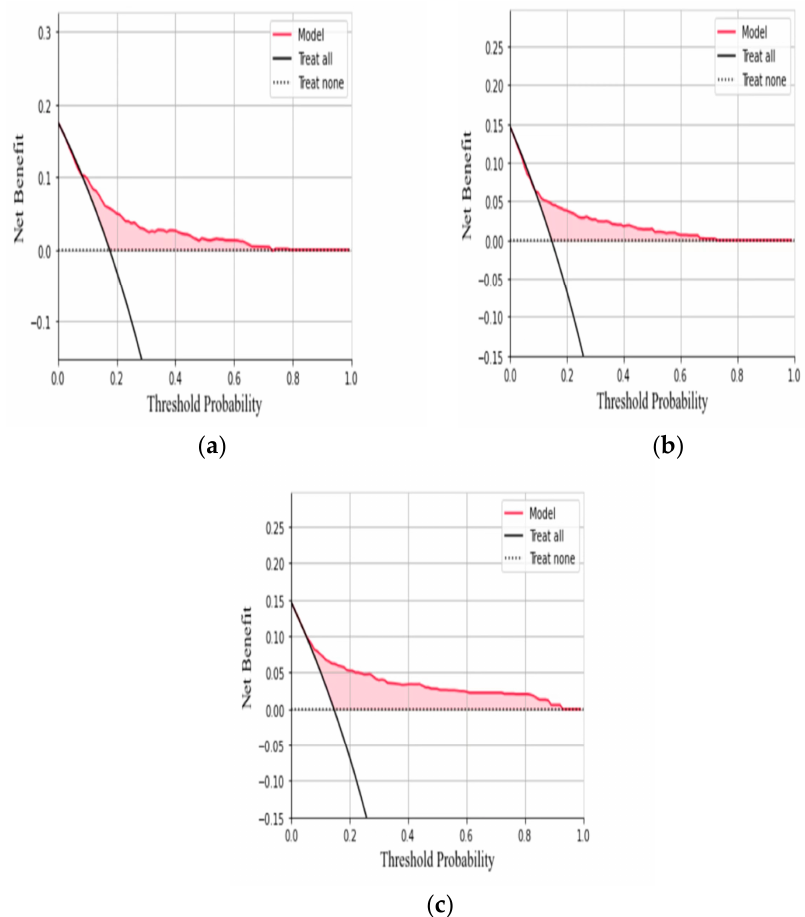
Figure 5. DCA curves of three models: ( a ) Logistic; ( b ) CNN; ( c ) XG Boost.